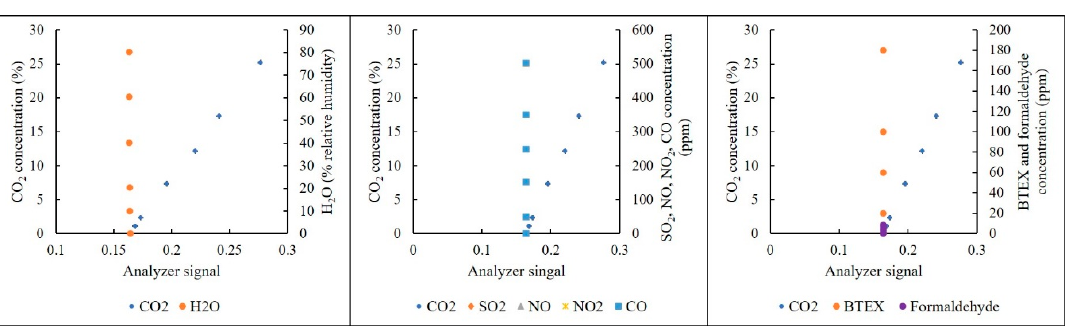
Figure 7. Effects of interference gases on the NDIR analyzer at the percentage channel.